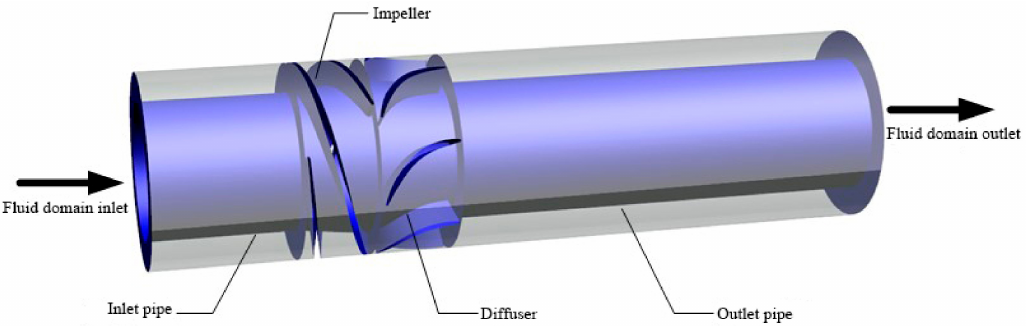
Figure 1. Computational model.